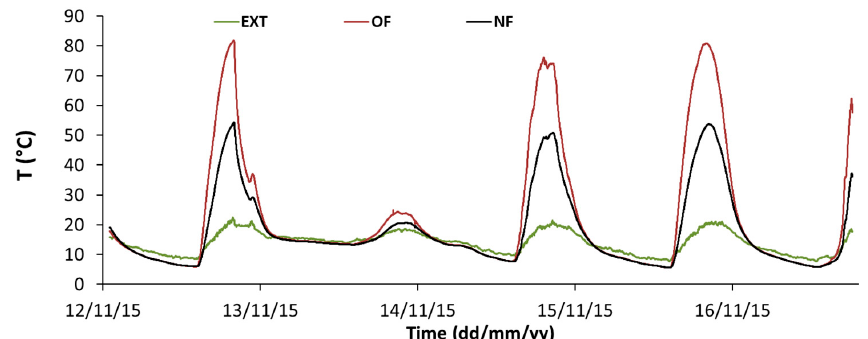
Figure 5. Temperature trends of ambient air and of the air inside the old framed (OF) and new framed (NF) boxes.